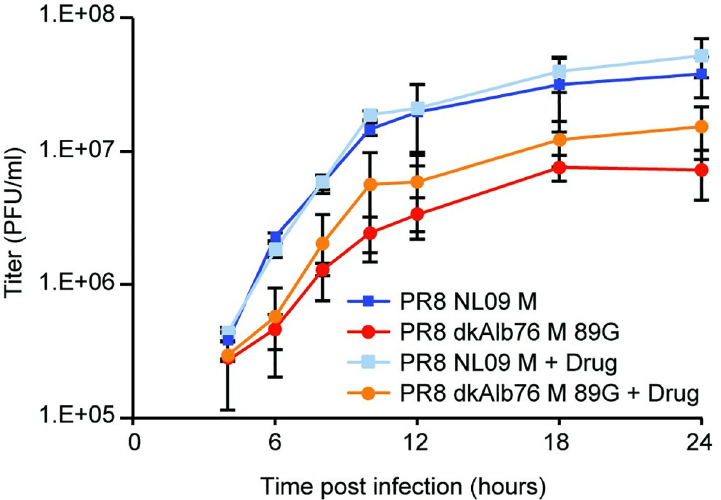
Fig 12. Amantadine improves growth of avian M segment-encoding virus in A549 cells. PR8-based NL09 M or avian M-encoding viruses were inoculated at an MOI of 5 PFU/cell onto A549 cells. At 1hpi, cells were treated with 200 μ M amantadine, and incubated at 37˚C for 24 h in the continuous presence of amantadine. Virus released into supernatant was collected at the indicated time points, and virus growth was measured by plaque titration. The pH1N1 M segment conferred more rapid kinetics and higher peak titers of growth than the avian-origin M segment, however amantadine had no impact on the growth of the pH1N1 M encoding virus. In contrast, growth of the avian M- encoding virus was improved in the presence of drug (P = 0.0007). Single-cycle growth was assessed in four independent experiments, with three technical sample replicates per experiment. Graphs show the means with SD for the four experiments. Statistical significance was determined using repeated measures, two-way, multiple comparisons ANOVA on log-transformed values, with Sidak’s correction